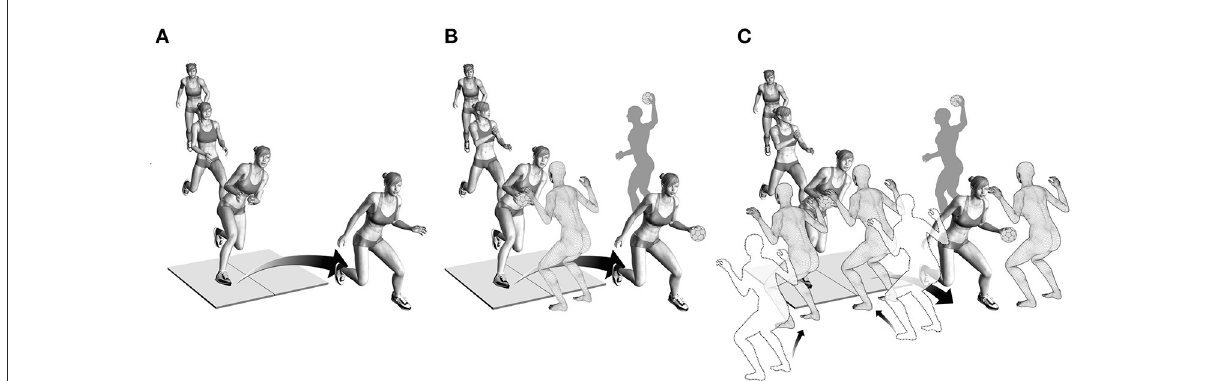
FIGURE1 (A) Illustration of task 1. Players approached the force plate and performed a pre-planned fake-and-cut maneuver. (B) Illustration of task 2. Players caught a ball passed by a teammate while approaching the force plate and performed a pre-planned fake-and-cut in front of a static defender. (C) Illustration of task 3. Players caught the ball passed by a teammate while two of the three defenders moved toward the athlete to block one side. This scenario forced the athlete to cut to the unblocked side, resulting in an unanticipated